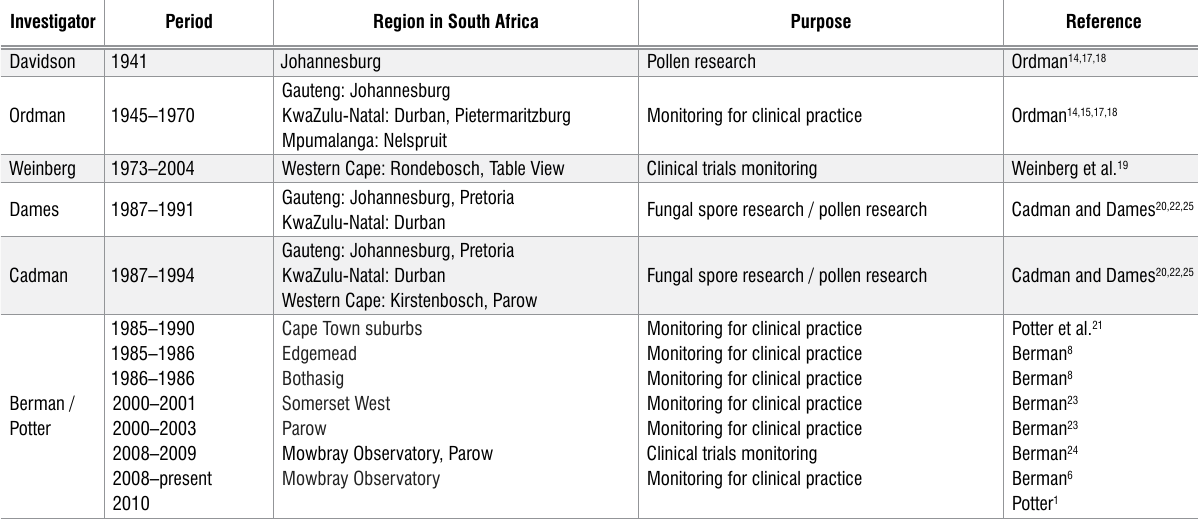
Historical and chronological order of aeropalynology studies and purpose of each study (updated/modified from Buters et al. 5